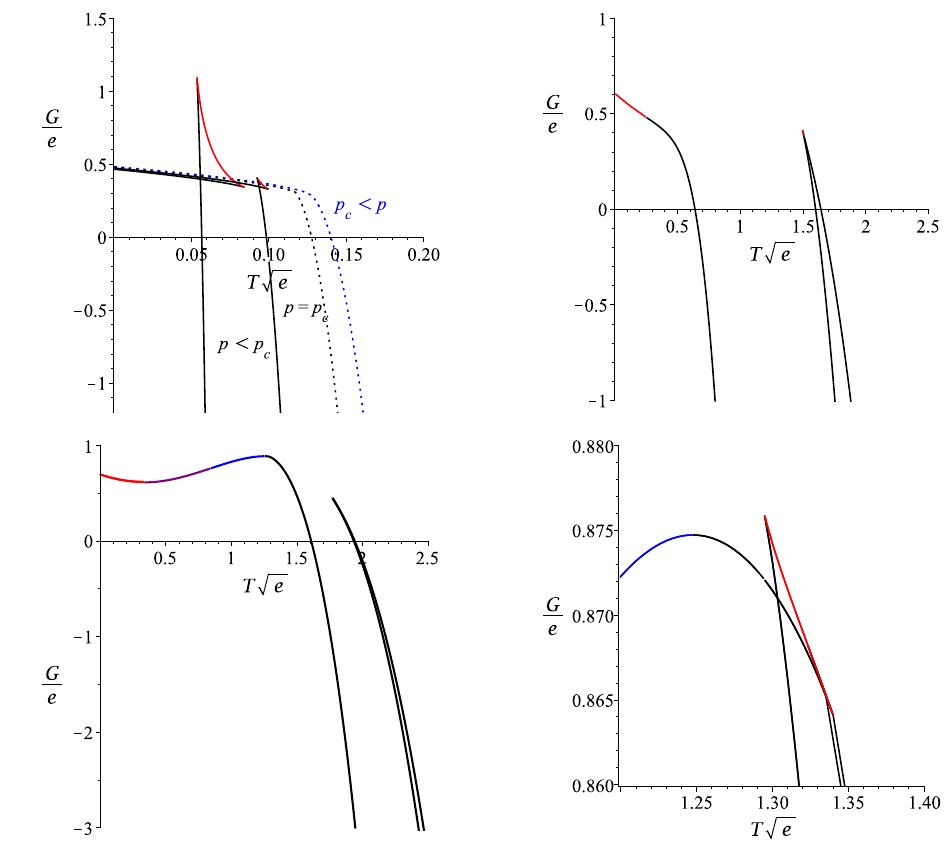
Figure 8 . Free energy as a function of temperature for d = 5 ; k = 1 (color online). We set p e = 1, (cid:12) 3 = (cid:0) 4 = 5 e 2 and (cid:11) 4 = (cid:0) 4 = 5 e 3 . Dimensionless critical quantities are T c e (cid:25) 0 : 11730 and p P c e (cid:25) 0 : 01686, T c e (cid:25) 1 : 28065 and P c e (cid:25) 0 : 40771, and appropriate powers of the electric charge parameter e are used to render the relevant quantities dimensionless. In each plot, red lines depict the parts of the curves for which the speci(cid:12)c heat is negative, blue lines indicate negative entropy, and the purple line indicates that both speci(cid:12)c heat and entropy are negative. Top left: the low temperature region (for which there is a standard VdW phase transition), with P = 1 : 2 P c (dotted, blue curve), P = P c (dotted, black curve) and P = 0 : 6 P c ; 0 : 2 P c (solid, black and red curve) each plotted. The remaining graphs pertain to the high temperature region (for which there is a reverse VdW phase transition). Top right: P = 0 : 5 P c , Bottom left: P = P c Bottom right: P = 0 : 99 P c